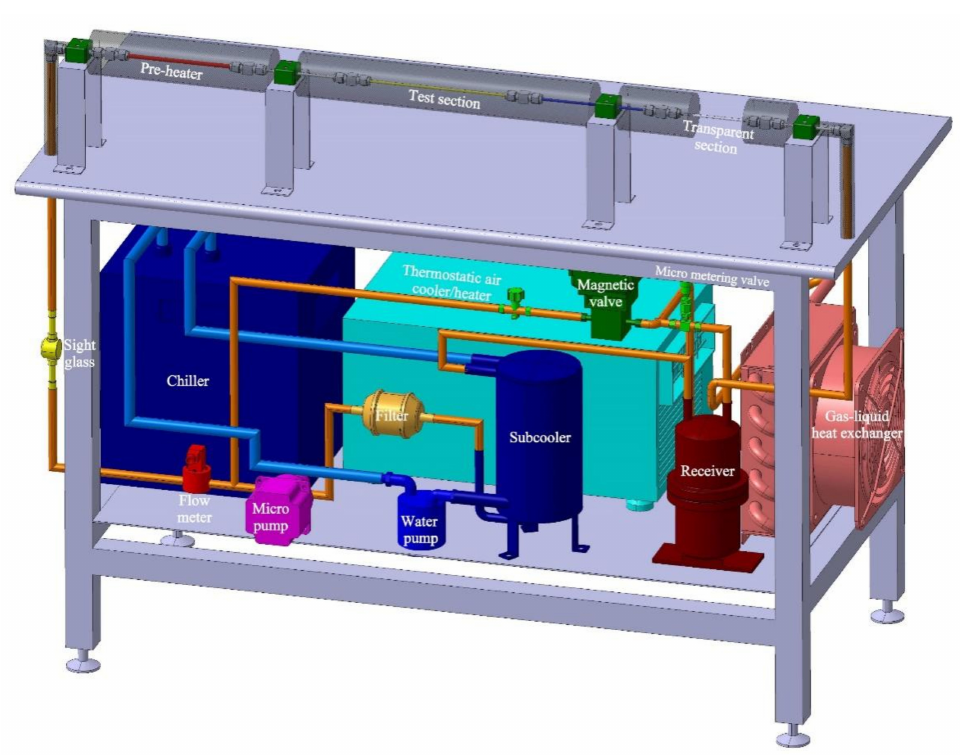
Figure 2. Experimental system: 3D